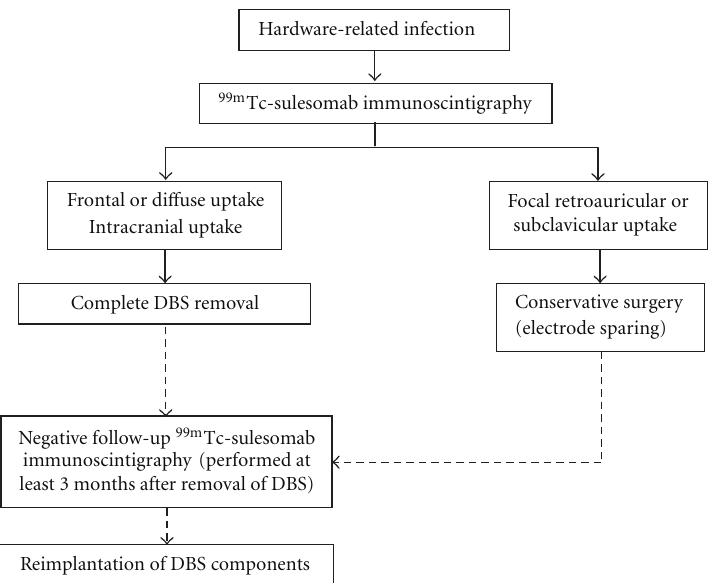
Figure 2: Proposed algorithm for the management of hardware-related